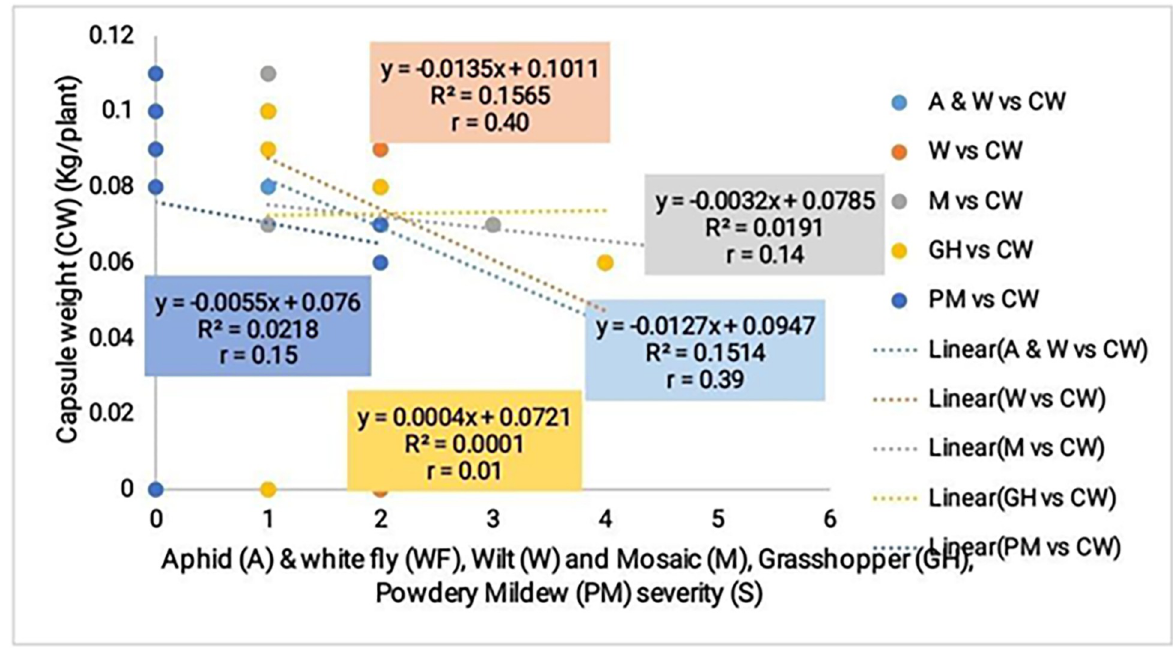
Fig 4. Correlation of pest and disease severity with okra